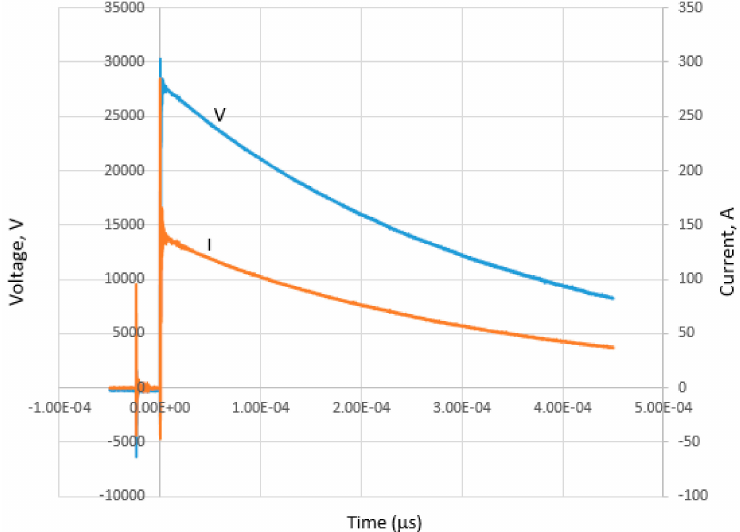
Figure 20. Voltage and current traces of 1-rod, at a charging voltage of 30